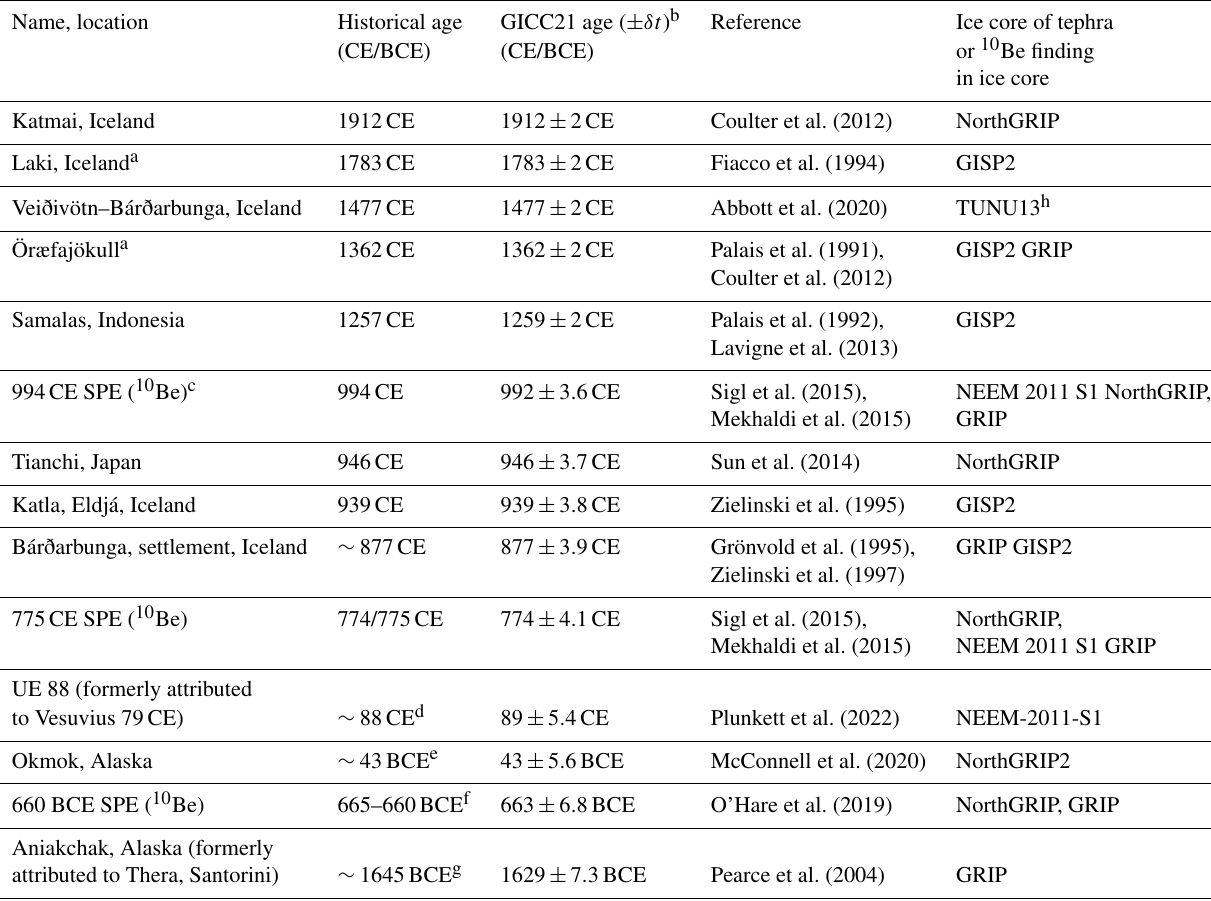
Table 3. GICC21 ages of chronostratigraphic markers in the Holocene which were important for this study. Tephra from eruptions and 10 Be from solar proton events (SPEs) both provide chronological references when the age of the event is known from historical evidence or other accurate timescales, such as